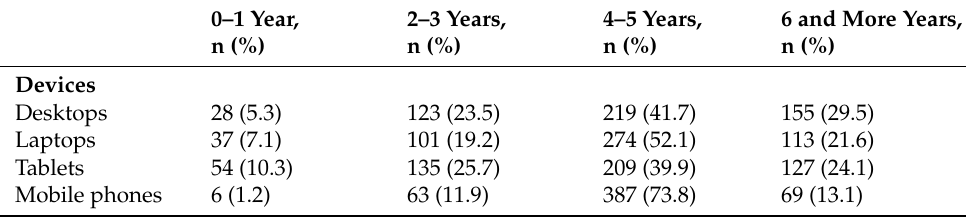
Table 4. The span of technology usage (Years) (n =